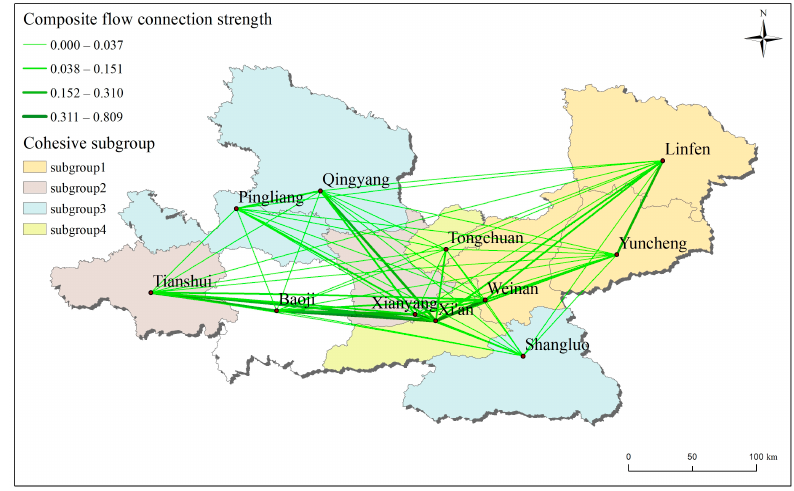
Figure 5. Spatial connection pattern of composite flow and analysis results of cohesive